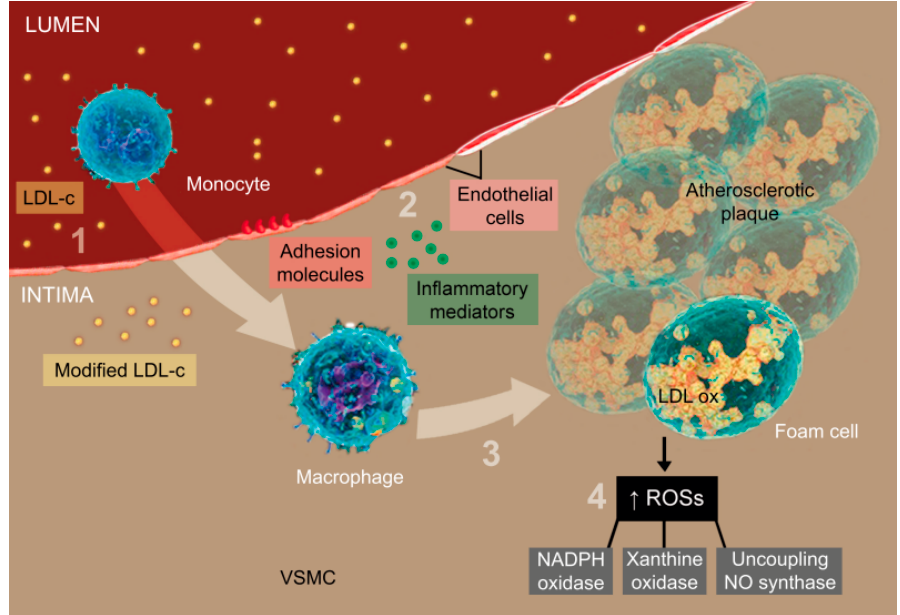
Figure 1. Representation of the atherosclerotic process adapted from Glaudemans et al. [40]. (1) Migration of LDL-c to the endothelial wall and its modification; (2) Uptake of the